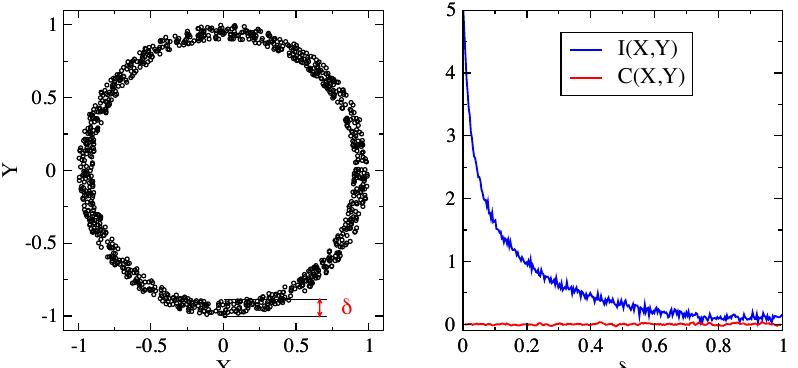
Figure 1. Illustration of the sensitivity of mutual information I ( X , Y ) to detecting the nonlinear de- pendence between two random variables X and Y compared with the Pearson correlation coefficient C ( X , Y ) . ( Left ) sample of dots ( X , Y ) with uniform distribution over an annulus of mean radius r 0 = 1 and thickness δ . ( Right ) mutual information and Pearson correlation coefficient of samples with different thickness. No correlation is found by the Pearson